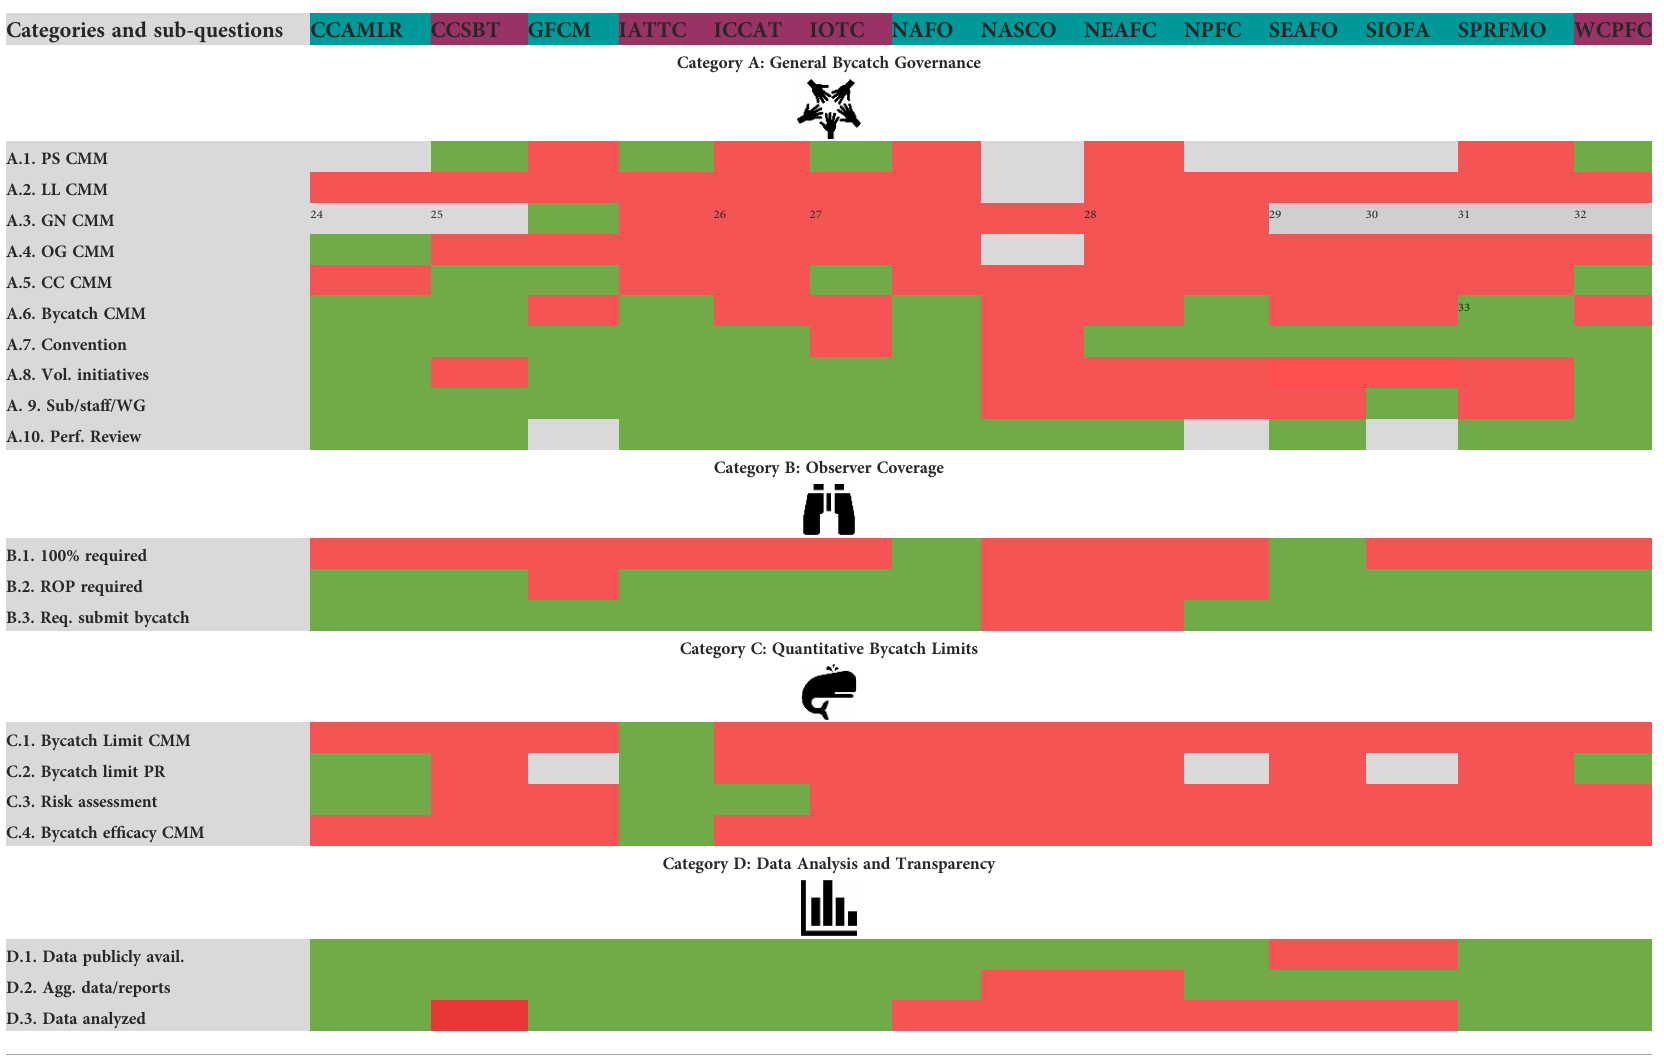
TABLE 3 Scores by RFMO for each question. A red cell indicates the RFMO did not have the relevant criterion, green indicates they did have the criterion, and grey indicates the question did not apply to the